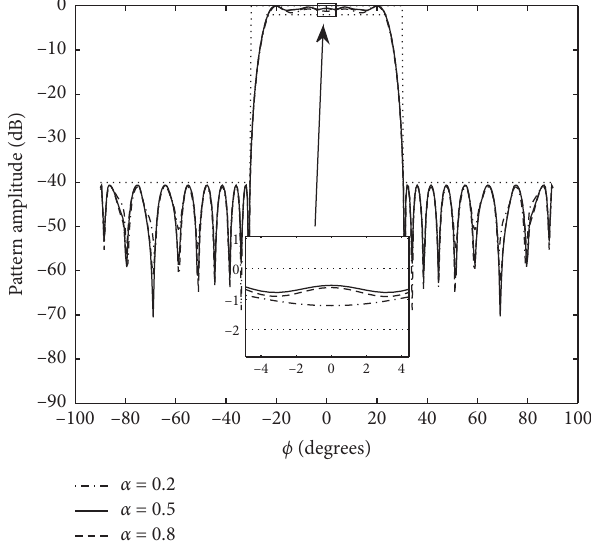
Figure 9: Copolarization components with different α